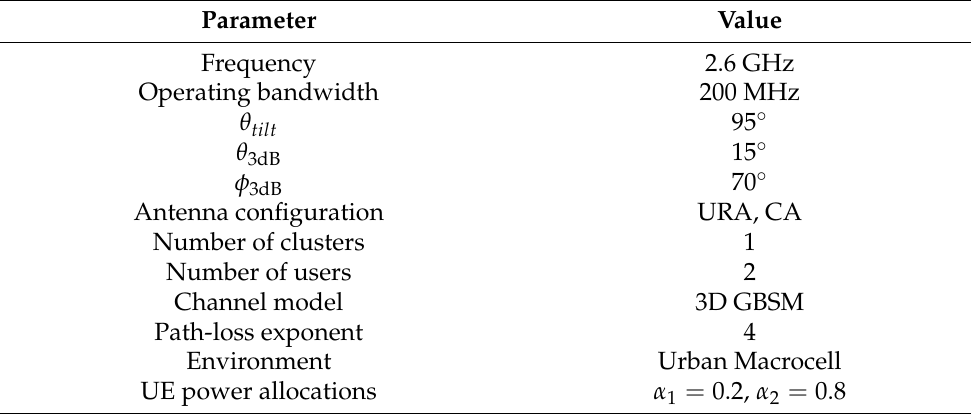
Table 2. Simulation